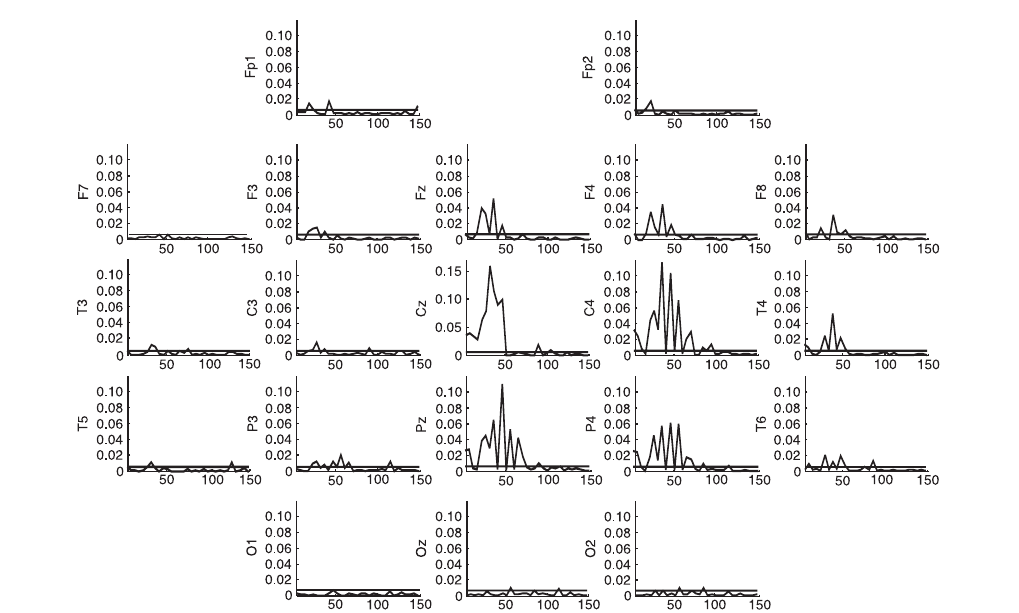
Figure 4. Magnitude-squared coherence (MSC) topography for volunteer #5. The abscissa is the frequency (Hz) and the ordinate is the MSC (dimensionless). Horizontal line is the critical value = 0.006, for α = 5% and M = 500.